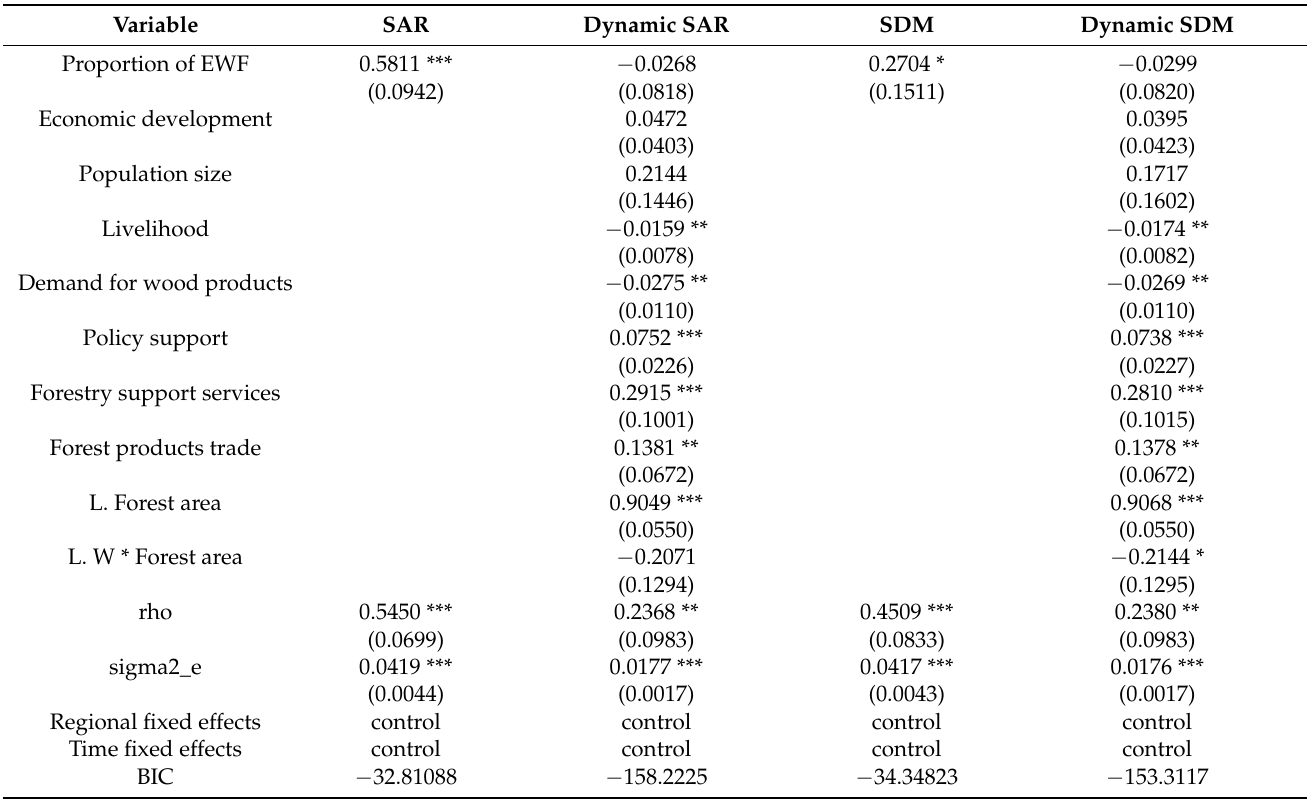
Table 2. Effects of the EWF-certified area on forest